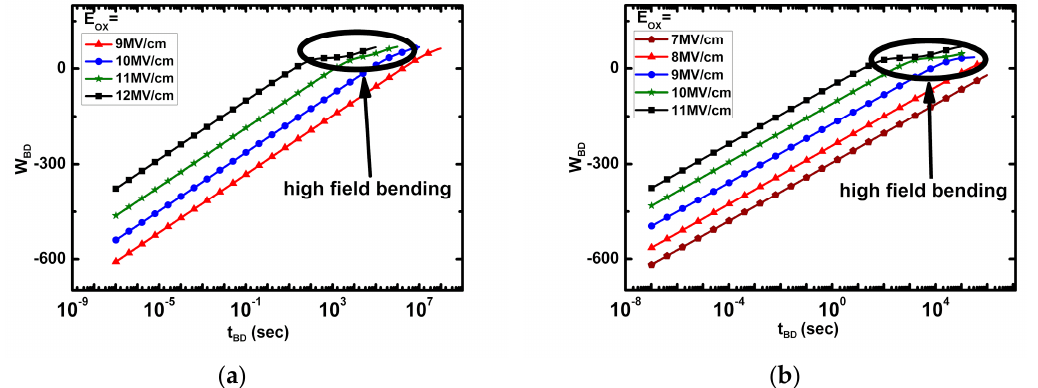
Figure 3. Weibit ( 𝑊 (cid:3003)(cid:3005) ) vs 𝑡 (cid:3003)(cid:3005) plot obtained from the proposed TDDB hybrid model: ( a ) Weibit at low Figure 3. Weibit ( W BD ) vs t BD plot obtained from the proposed TDDB hybrid model: ( a ) Weibit at low temperature (298.15 K); ( b ) Weibit at high temperature (398.15 K). temperature (298.15 K); ( b ) Weibit at high temperature (398.15 K).